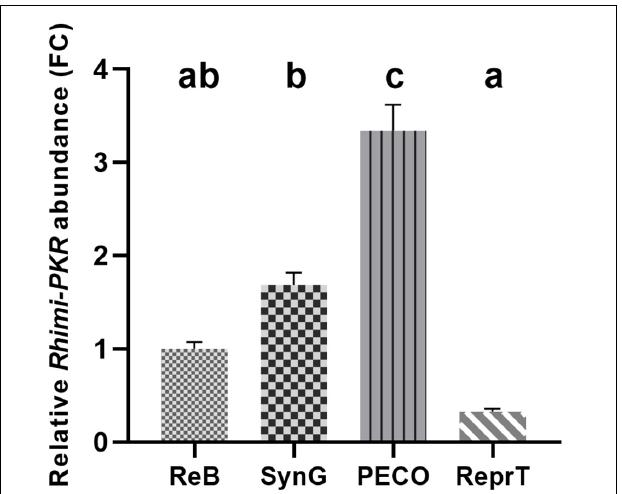
FIGURE 4 | Relative quantification of pyrokinin receptor transcripts in different tissues of Rhipicephalus sanguineus using RT-qPCR. The relative abundances of PKR transcripts across different tissues including reproductive tissues (ReprTs), synganglion (SynG), pharynx-esophagus, chelicera, and other soft tissues associated with capitulum (PECO) and the rest of the body (ReB) from unfed adult female of R. sanguineus (2–3-month-old) were compared. Tissues from three ticks were pulled for each replicate; a total of 9 ticks were used for three replicates. Two internal reference genes (elongation factor 1-alpha and ribosomal protein S4) were used to normalize the PKR abundance of each replicate. The relative abundance of transcripts in each tissue was expressed as FC of PKR transcript abundance compared with the transcript abundance of ReB (mean ± SEM, n = 3). One-way ANOVA followed by a Tukey’s multiple comparisons test was performed to test the difference in relative PKR abundance; different letters in the figure indicate significant difference, P <